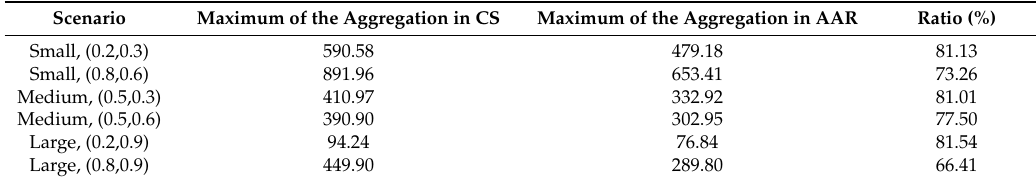
Table 3. Maximum of the aggregation in two schemes.